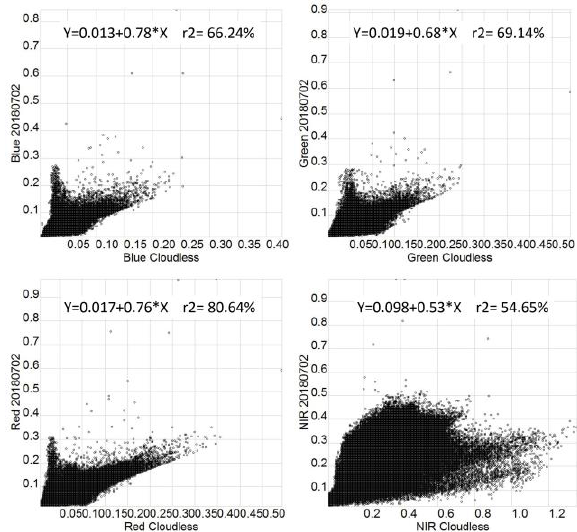
Figure 12. Scatterplots of reflectance values, along the 20 km2 sample, among the cloudless image and the reference Sentinel-2 image. From top left, to bottom right image: Blue, Green, Red, and NIR band